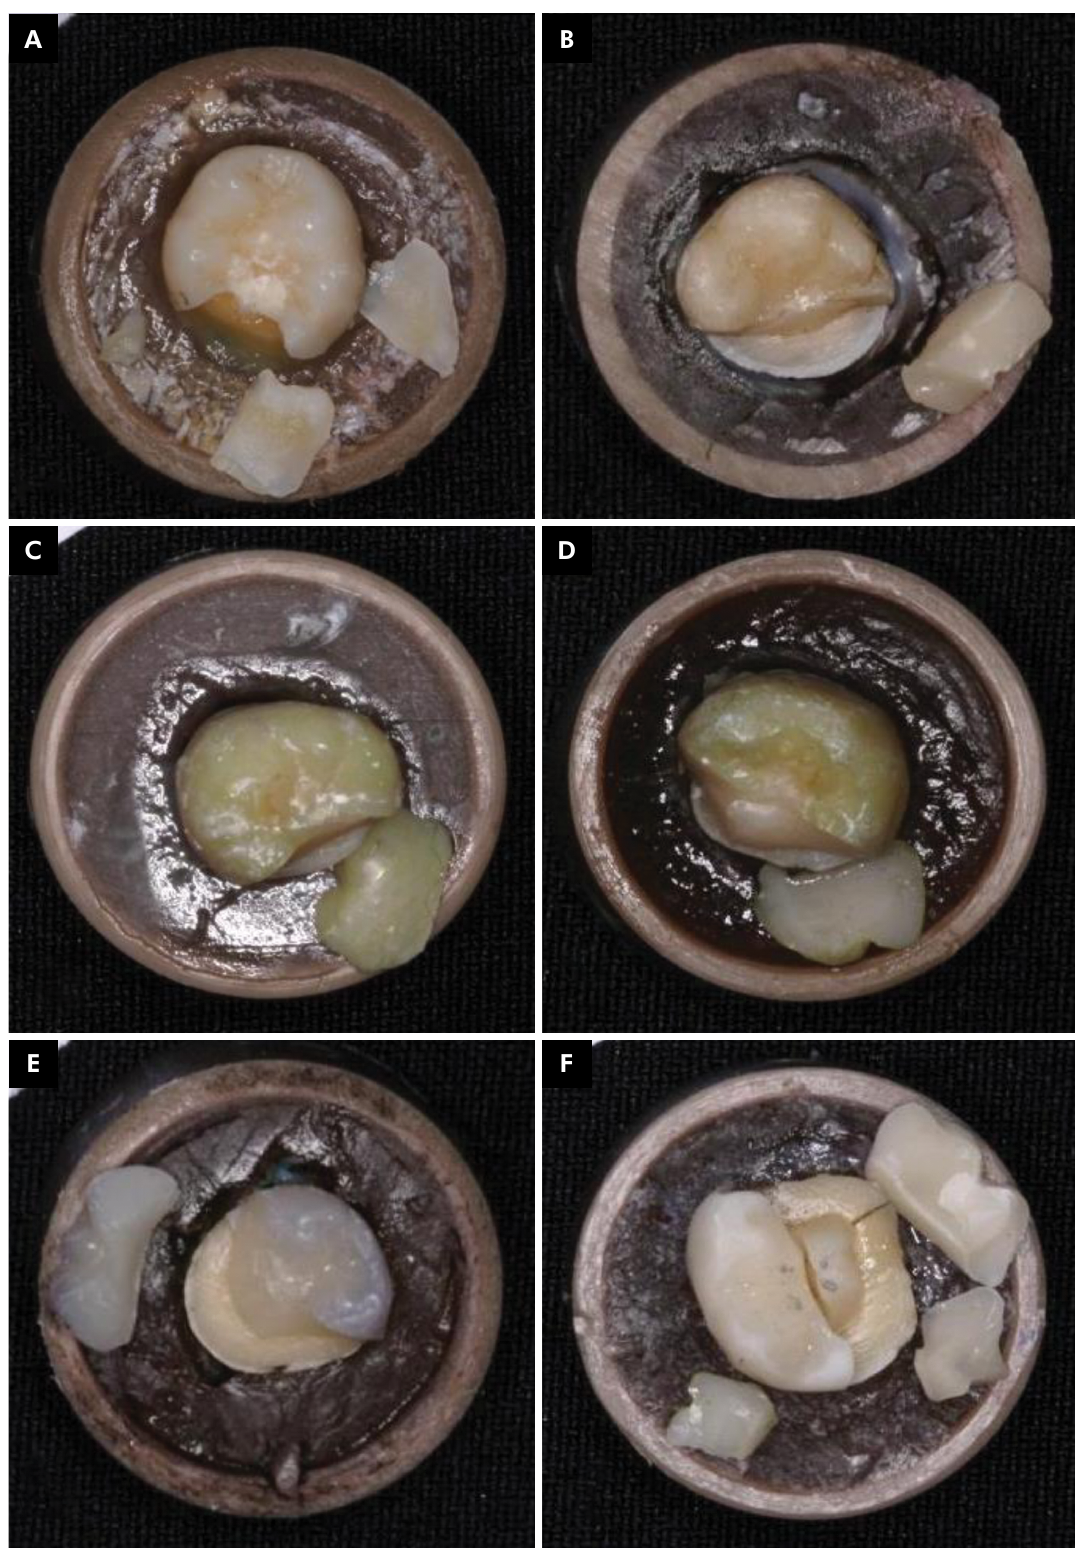
Figure 3. Representative images of the most frequent failure mode observed for all groups tested in the